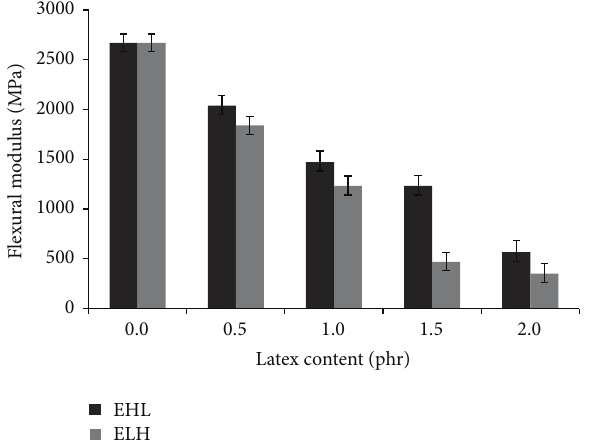
Figure 5: The flexural modulus of porous epoxy extracted by toluene using mixing sequence of EHL and ELH,